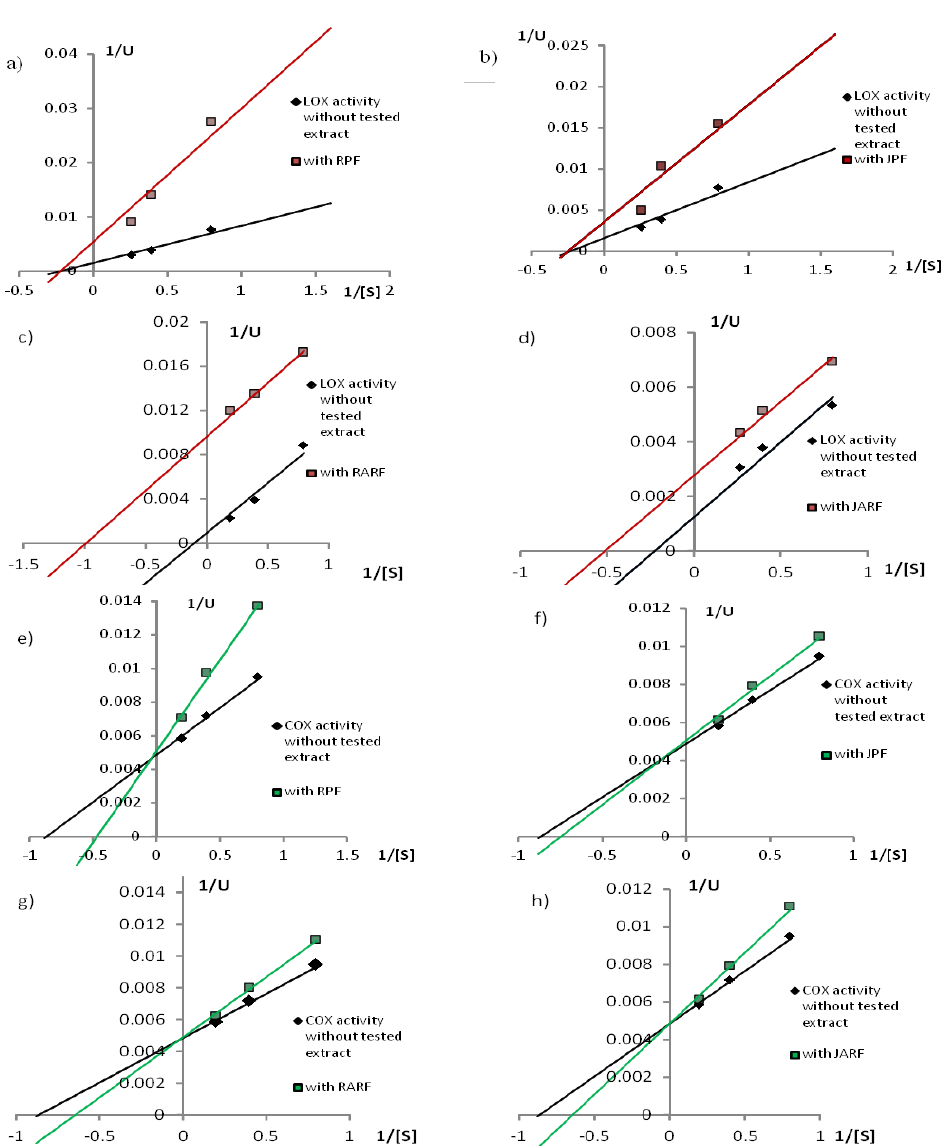
Figure 2. Mode of LOX ( a—d ) and COX ( e—h ) inhibition by analyzed extracts: RPF — raspberry phenolic fraction, RARF—raspberry anthocyanin-rich fraction, JPF—raspberry juice phenolic phenolic fraction, RARF — raspberry anthocyanin-rich fraction, JPF — raspberry juice phenolic fraction, JARF — raspberry juice anthocyanin-rich fraction. Control — the activity of enzyme without tested extract.